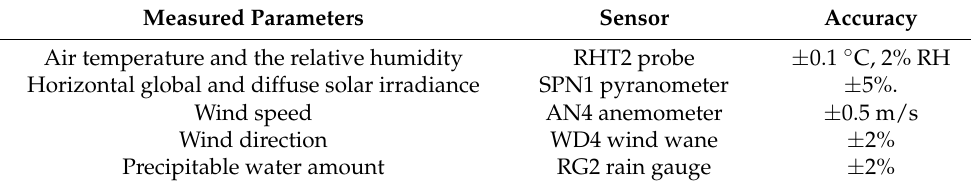
Table 2. Characteristics of the weather station monitoring devices.